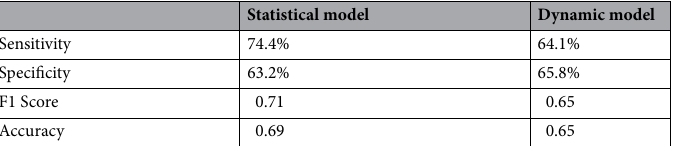
Table 4. Sensitivity, specificity, F1 scores and accuracy of the final (test) models for group classification (circadian/non-circadian) using predicted DLMOs (true positives = circadian, true negatives =